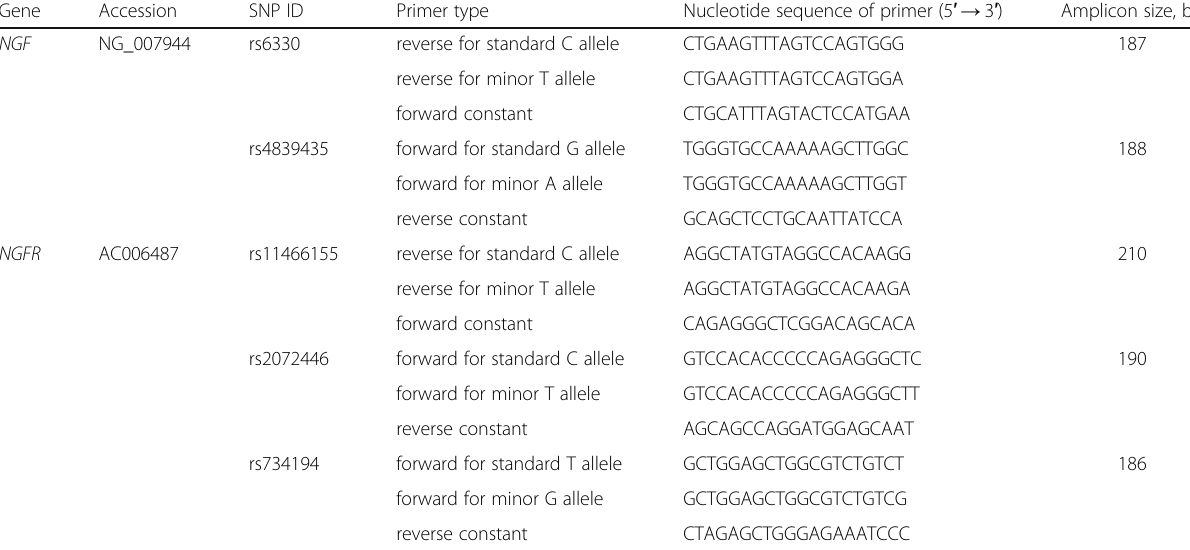
Table 1 The primer sequences and amplicons size of the studied